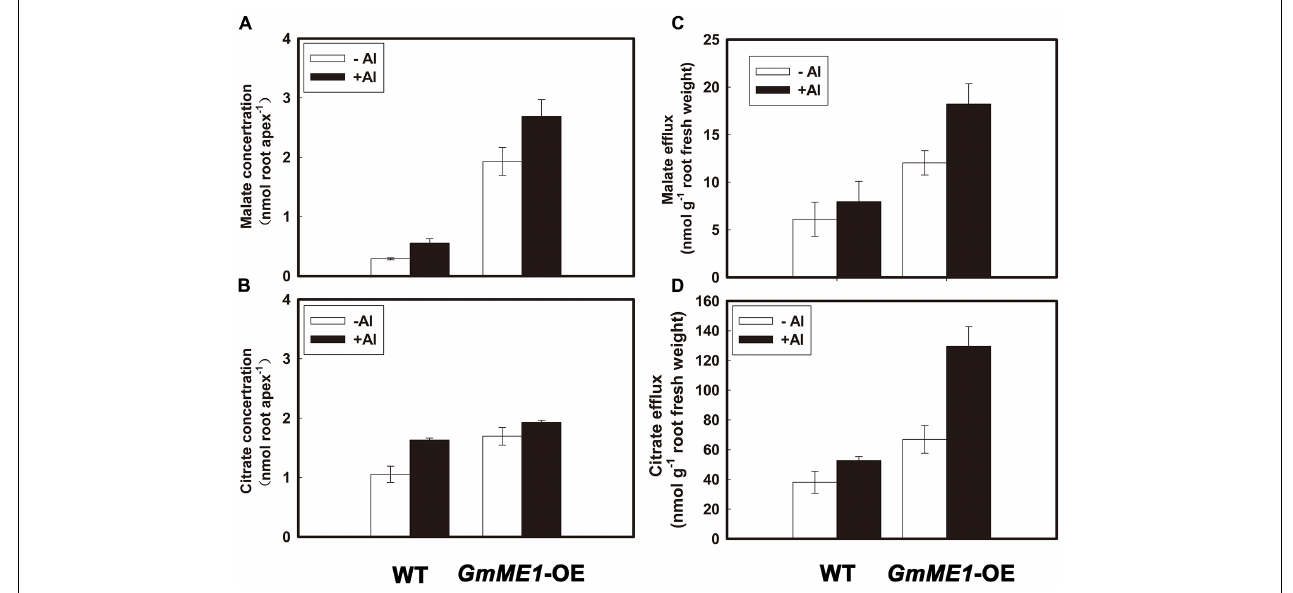
FIGURE 6 | Concentration and efflux of malate (A,C) and citrate (B,D) in soybean hairy roots of GmME1 -OE under Al stress. Both transgenic and WT hairy roots were exposed to 0.5 mM CaCl 2 solution (pH 4.5) with or without 30 µ M AlCl 3 for 4 h. Ten root apices were excised from each treatment for malate (A) and citrate (B) concentration analysis. Root exudates were collected for malate (C) and citrate (D) efflux measurement. Fresh root biomass was weighed immediately. Data are given as the mean ± SD ( n = 3).